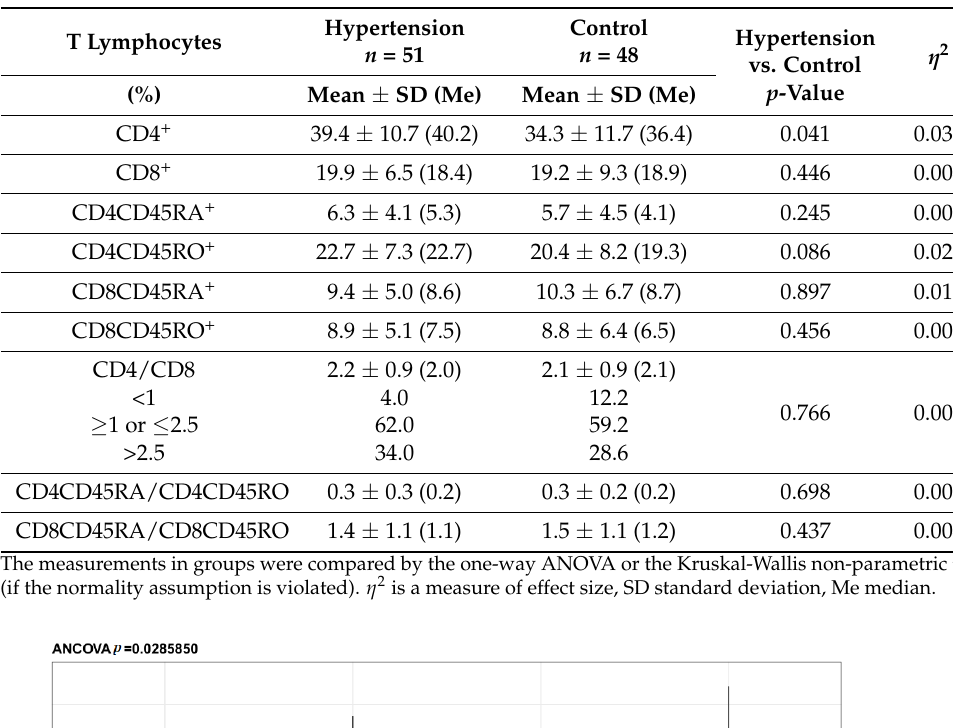
Table 3. Distribution of T lymphocytes in patients diagnosed with hypertension when compared to controls.